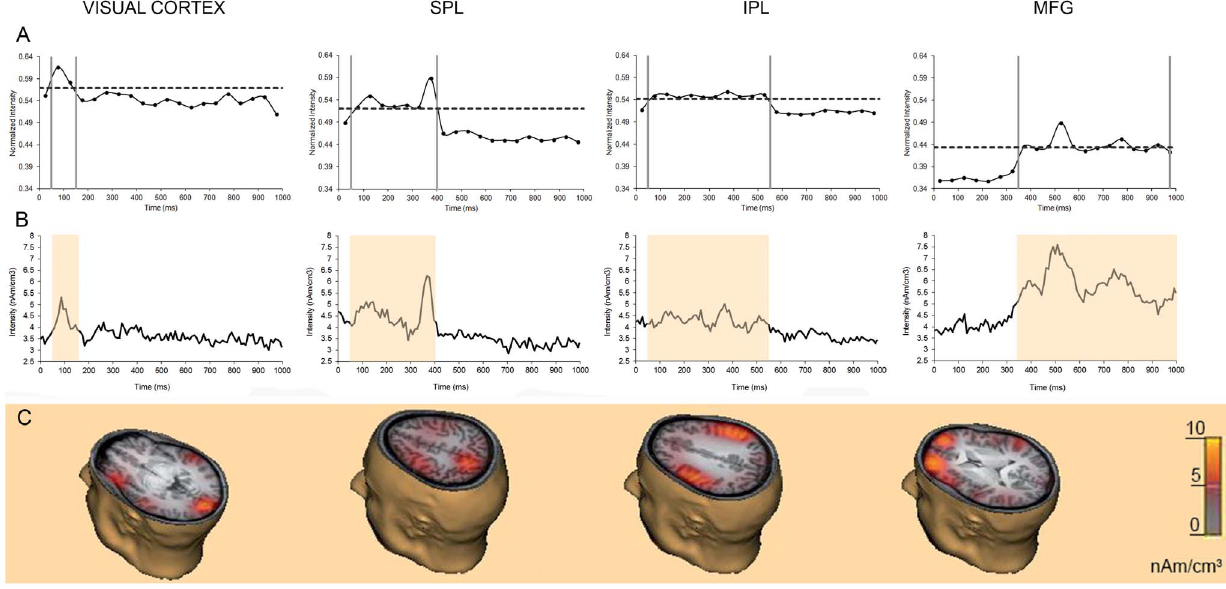
Figure 3. MEG results. A: Mean normalized intensity across all conditions and subjects over time for selected ROIs. Vertical bars indicate the temporal intervals with the highest intensity values established by statistical analysis. Horizontal line indicate the cut-off value (mean + sd). B: Group mean temporal activity was averaged for all conditions for areas showing strongest activity after the matching stimulus. Coloured bars indicate temporal intervals determined previously from statistical analysis and used in the following statistical analyses to compare source activity across conditions (50–150 ms for visual cortex, 50–400 ms for superior parietal lobe, 50–550 ms for inferior parietal lobe and 350–1000 ms for middle frontal gyrus); C: Spatial maps of activations for each areas.